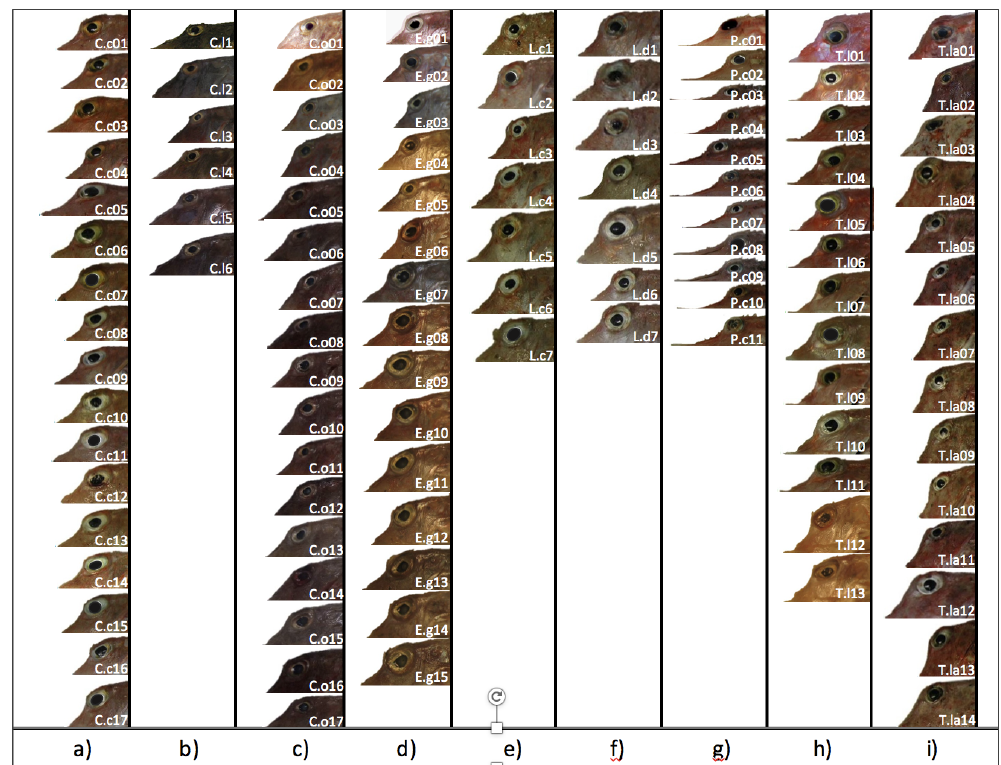
Figure 5. The images show the profiles of interest of the specimens in the database according to taxonomist